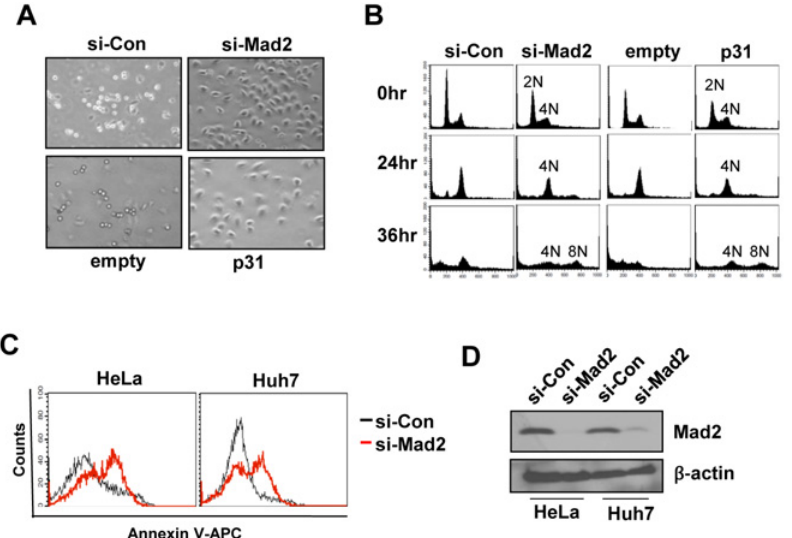
Fig 5. p31 comet overexpression leads to mitotic failure similar to Mad2 depletion. (A) Nocodazole was added to cultures of HeLa cells transfected with either Mad2 siRNA (si-Mad2) or control siRNA (si-Con) and transduced retrovirally with p31 comet or empty vector. Subsequent morphological changes were compared under a light microscope (x100). (B) Under the above conditions, cell cycle progression was monitored with histograms of the DNA content (2N, 4N and 8N) at 24 h and 36 h after treatment. (C) Apoptosis was analyzed via Annexin V staining in HeLa and Huh7 cells transfected with either Mad2 siRNA (si-Mad2) or control siRNA (si-Con). (D) Mad2 depletion with Mad2 siRNA was confirmed using Western